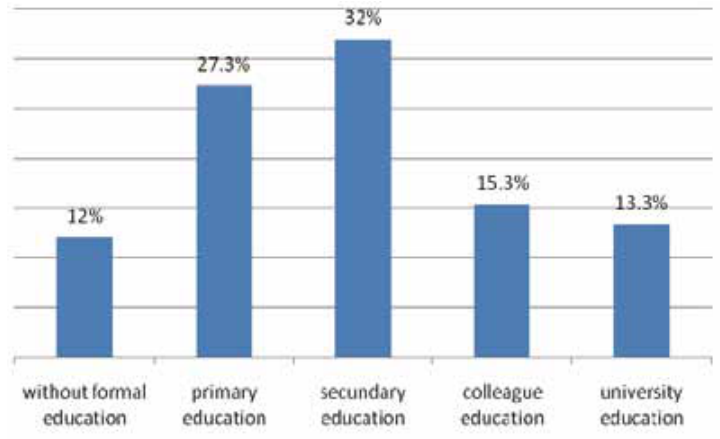
FIGURE 2. percentual representation per level of education